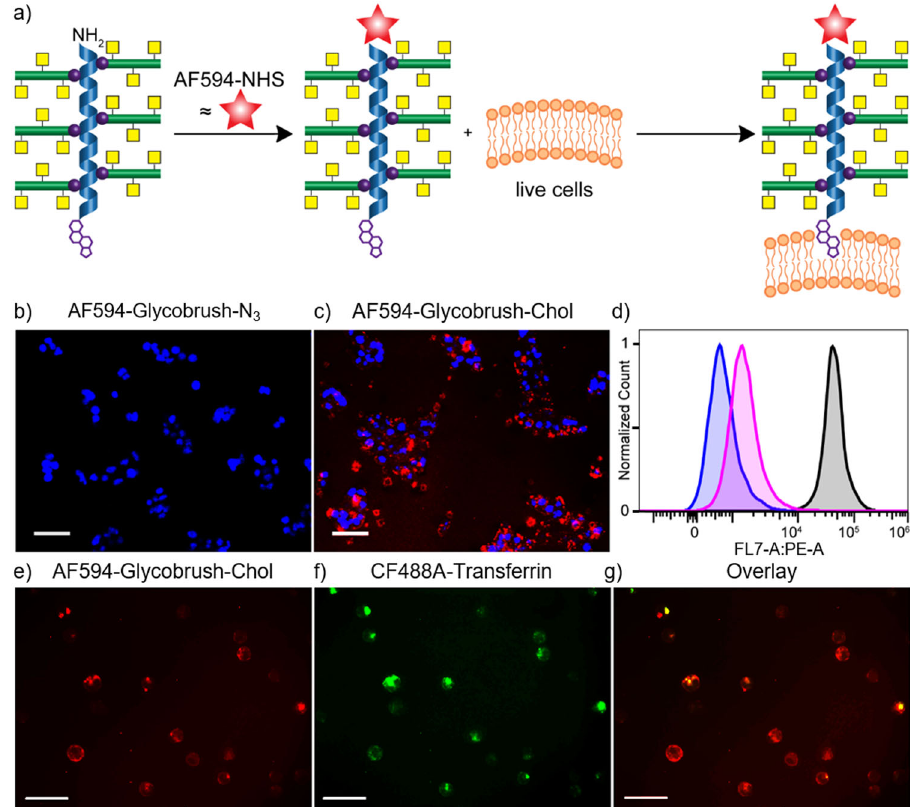
Fig. 5 Robust and prolonged glycocalyx engineering using Chol-terminal GalNAcS- glycobrushes. a Reaction scheme for conjugation of AF594-NHS to glycobrush (PLG 0.8 - s -PAIK 0.2 ) 50 - g -PGalNAcS 13 -Chol amino termini, followed by engineering of the glycocalyx of live epithelial cells. Cell images in b , c are 24 h after incubation b with 15 µ M AF594-glycobrush-N 3 or c with 15 µ M AF594-glycobrush-Chol. d Flow cytometry data of HEK293T cells untreated (blue) or treated with AF594-glycobush-N 3 (magenta) or AF594-glycobrush-Chol (black). Cell images in e – g are paraformaldehyde- fi xed HEK293T cells that were incubated with 15 µ M AF594-glycobrush-Chol and 30 μ g/mL CF488A-transferrin, where e is imaging for AF594-glycobrush-Chol, f is imaging for CF488A-transferrin, and g is the overlay of the images in e and f . Scale bars are 50 µ m. Images in b , c , e – g are representative of four separate